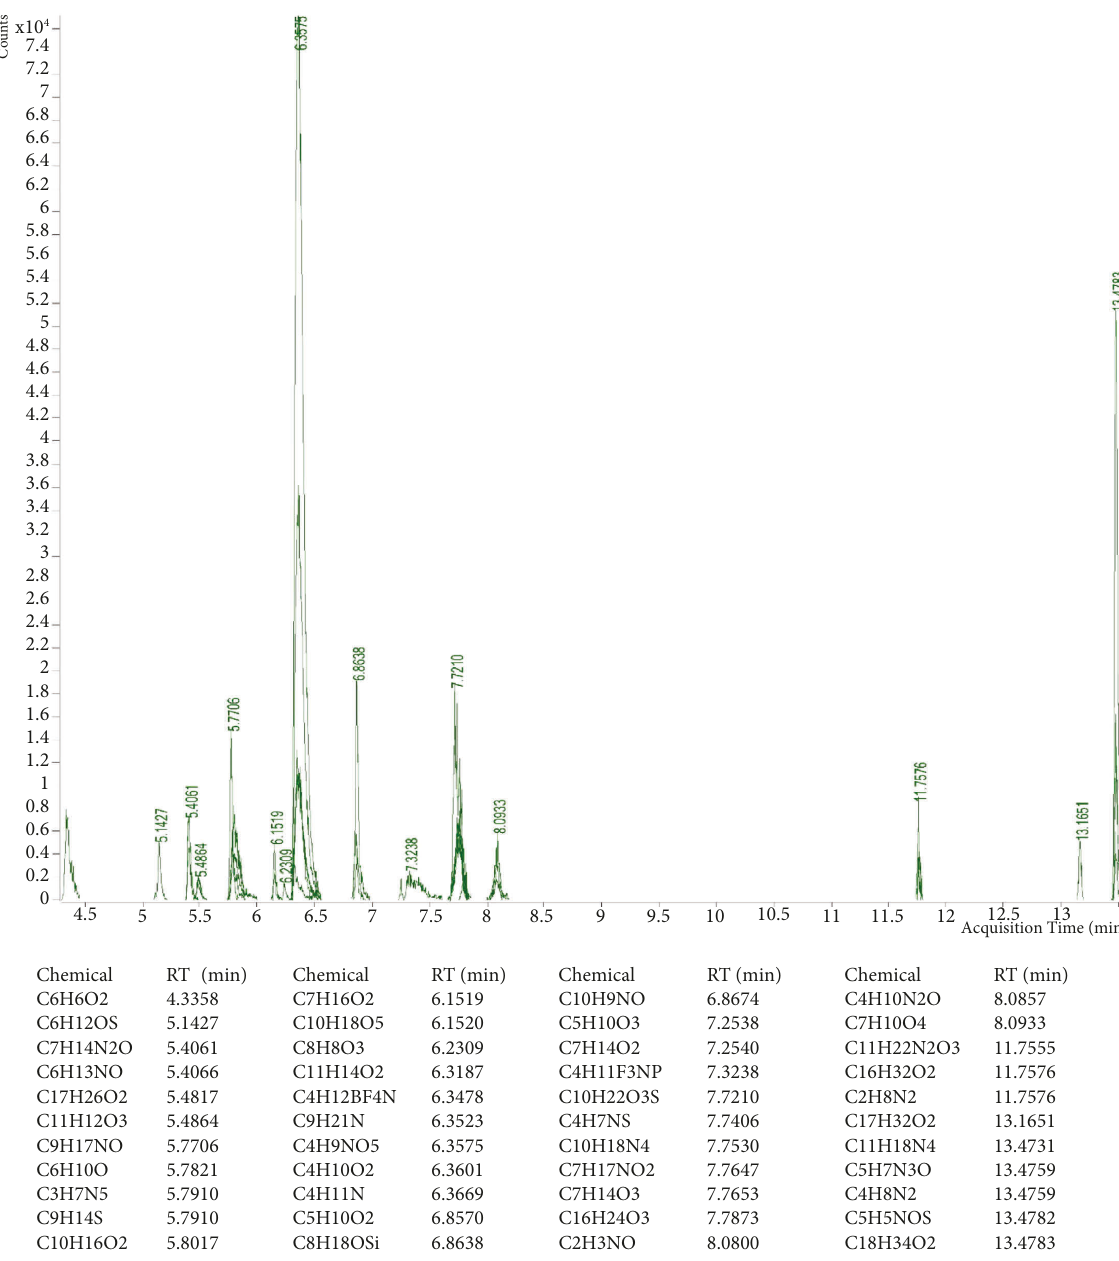
Figure 2: GC-MS chemical characterization of a nonpolar extract of date pits. RT: retention